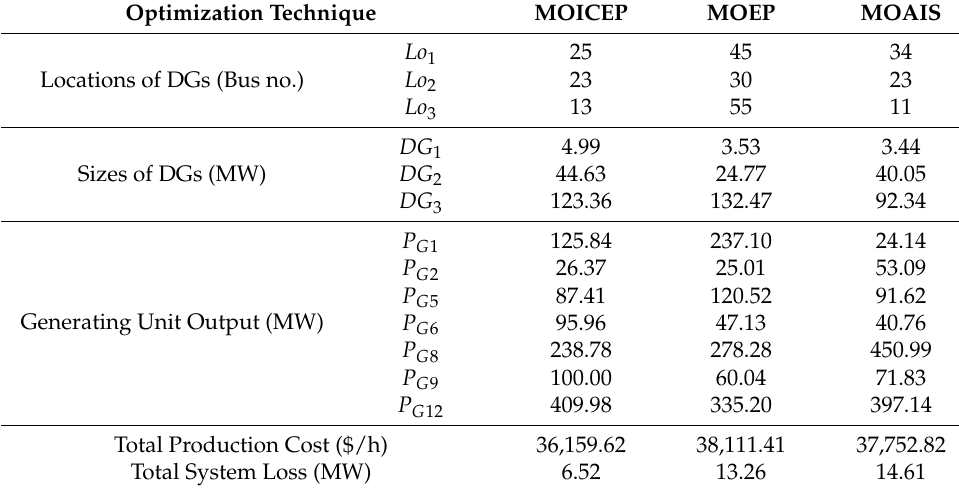
Table 7. Results of the integrated basic ED and DG installation of the IEEE 57-Bus RTS ( w 1 = 0.1 and w 2 =